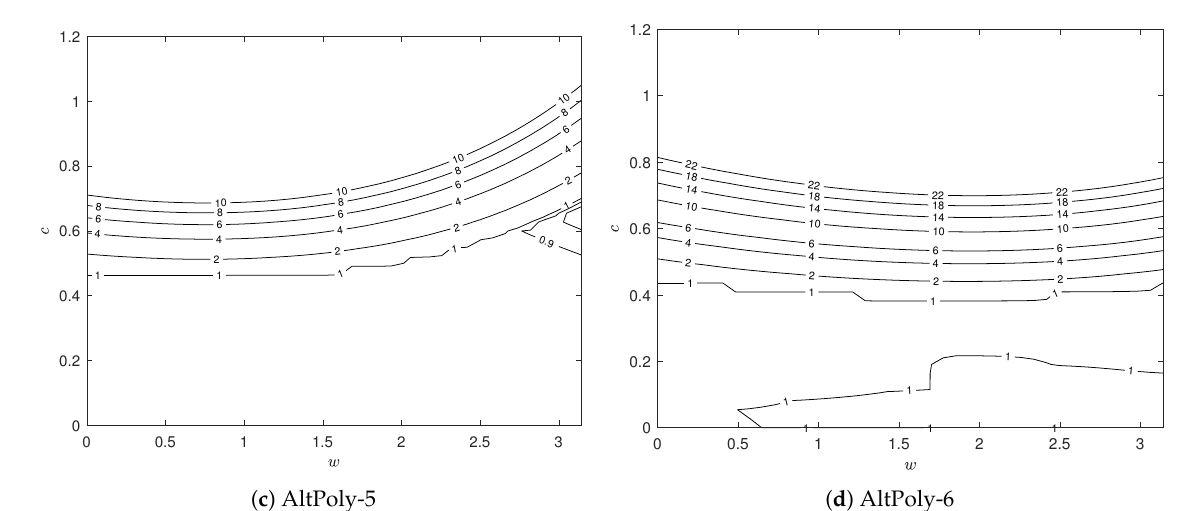
Figure 2. Contour plots of the principal eigenvalues of the amplification matrices of AltPoly schemes using fourth-order RK time integration for the linear advection